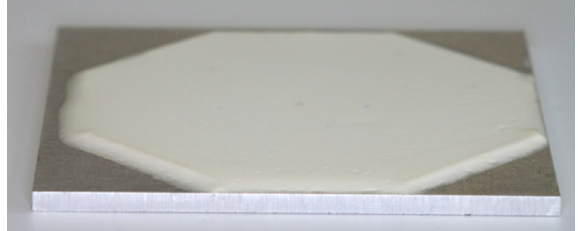
Figure 2. Sample Ct_610 with 0.61 mm coating thickness.